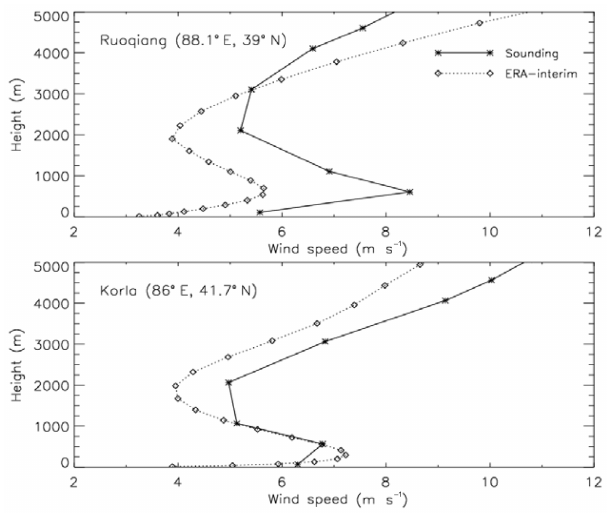
Figure 4. Mean wind speed profiles at 00:00UTC based on ra- diosondes (solid line) and ERA-Interim (dotted line) at (a) Ruo- qiang and (b) Korla sites for